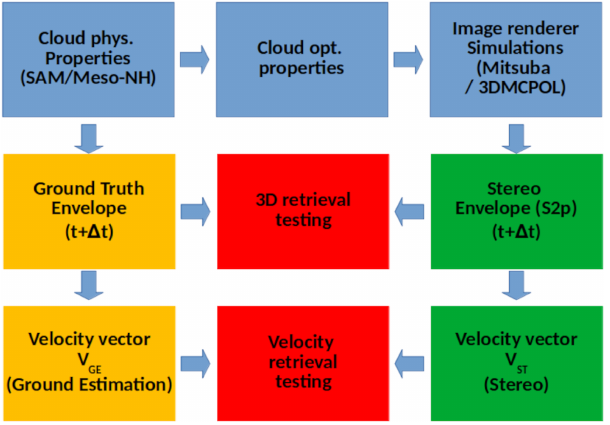
Figure 3. End-to-end CLOUD (C3IEL) simulator: methods and